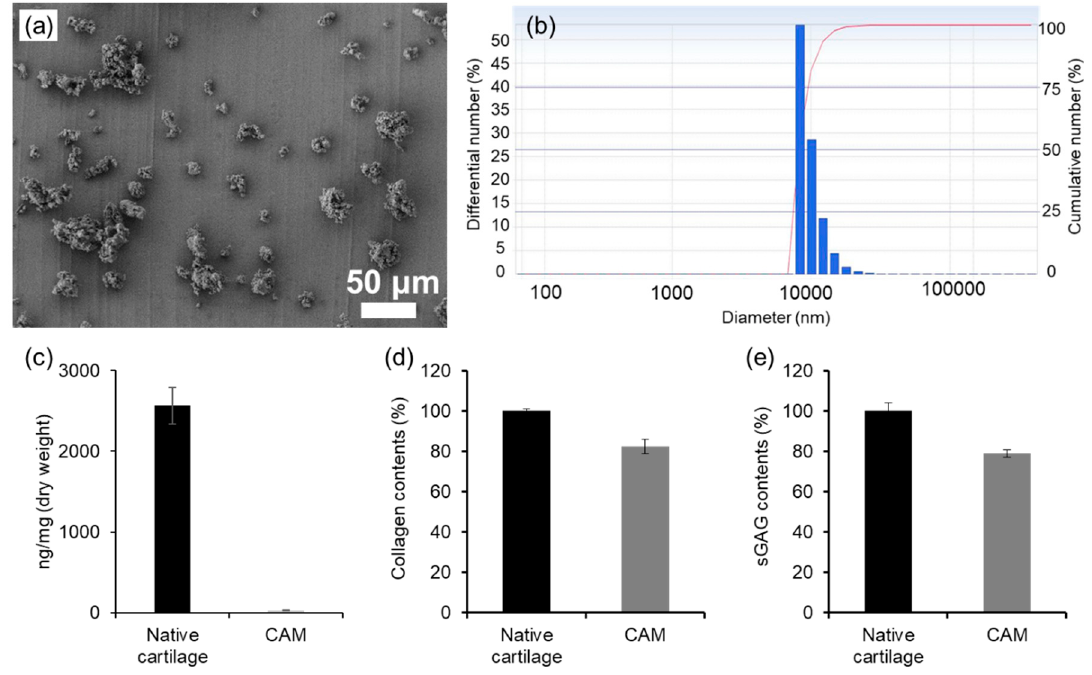
Figure 1. ( a ) SEM mages and ( b ) particle size of cartilage acellular-matrix (CAM) powder, and ( c ) DNA, ( d ) collagen, and ( e ) glycosaminoglycans contents of native cartilage and CAM.